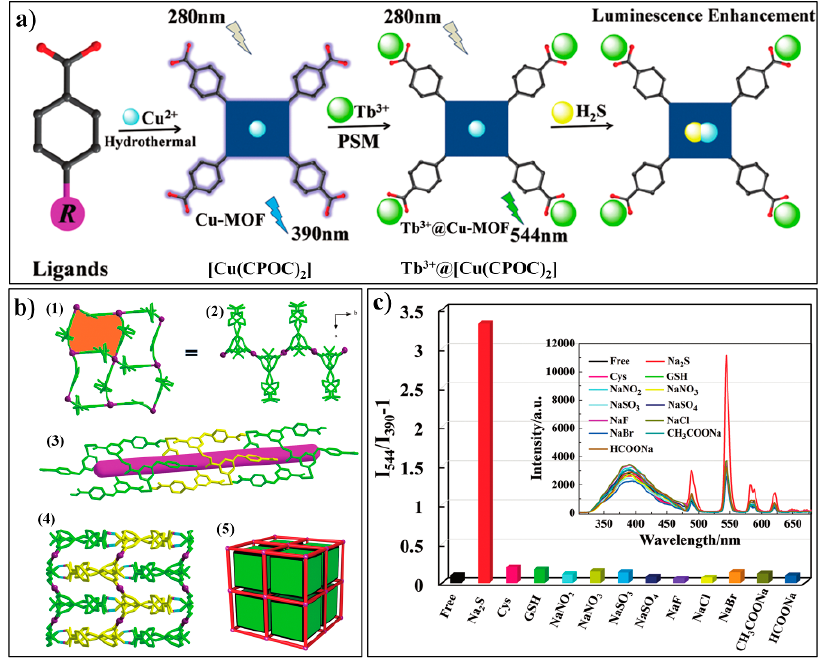
Figure 7. ( a ) Synthetic route for Tb 3+ @Cu-MOF and its sensing mechanism for H 2 S. ( b ) Crystalline structure of [Cu(CPOC) 2 ], (1) 2D layers of Cu1; (2) 2D layers of Cu1 viewed along the c axis; (3) 1D channel in the 3D framework; (4) 3D supramolecular framework of [Cu(CPOC) 2 ] through O–H ··· O interactions; (5) topological representation of the 3D structure. ( c ) Fluorescence response of Tb 3 + @[Cu(CPOC) 2 ] towards sulfide and other analytes. Reproduced with permission from [85]. Copyright the Royal Society of Chemistry,